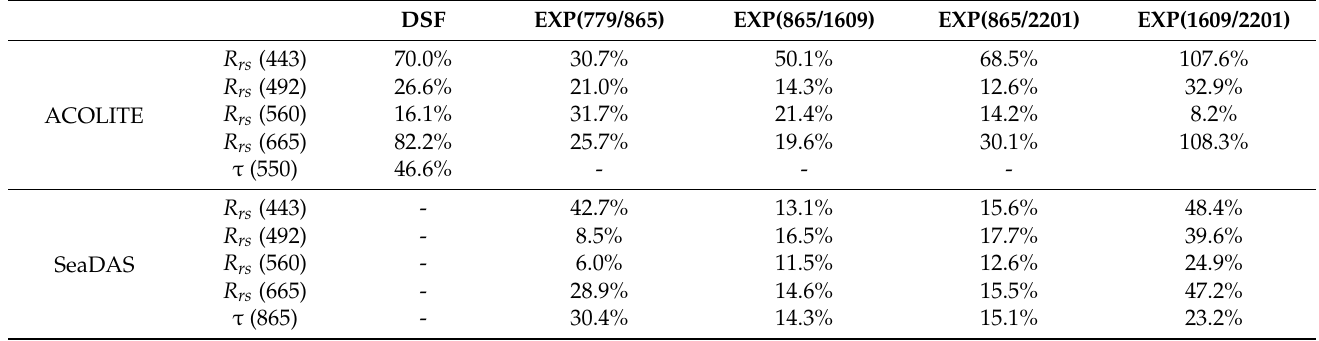
Figure 16. Validation of MSI-derived aerosol optical depth ( a ) at 550 nm, 𝜏 (550), using ACOLITE and ( b ) at 865 nm, τ (865), using SeaDAS with four band combinations (779/865, 865/1609, 865/2201, and 1609/2201).